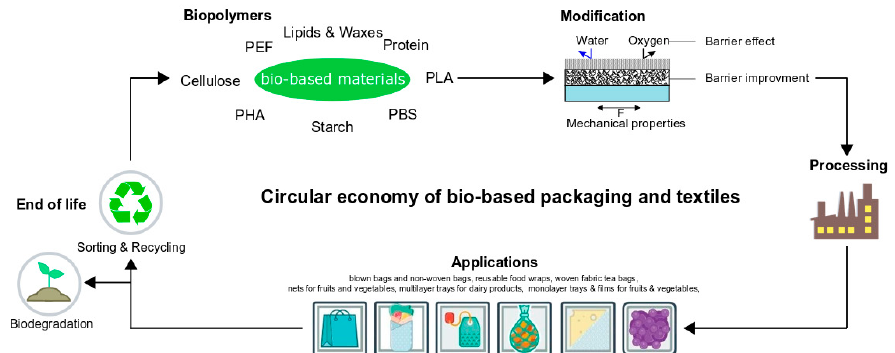
Figure 1. Schematic illustration of an ideal cycle of bio-based material to be used for packaging application (PLA: polylactic acid, PEF: polyethylene furanoate, PBS: polybutylene succinate, PHA: polyhydrodyalkanoate).